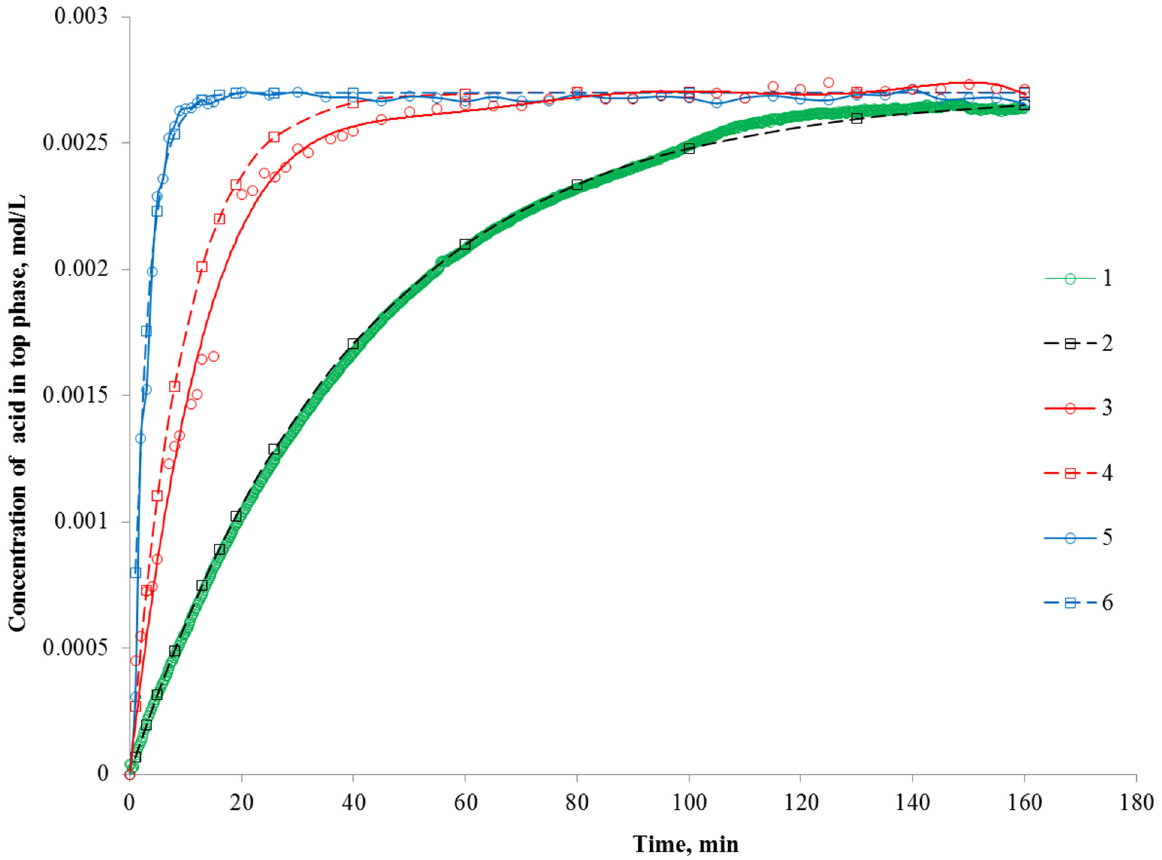
Figure 4. Comparative results of the extraction of sulfosalicylic acid using the PEG-1500-Na 2 SO 4 -H 2 O system with and without ultrasound and their agreement with theoretical calculations: 1.2 − P m = 0; 3.4 − P m = 0.6 bar; 5.6 − P m = 2.0 bar (experimental curves—solid line; theoretical curves—dashed line).